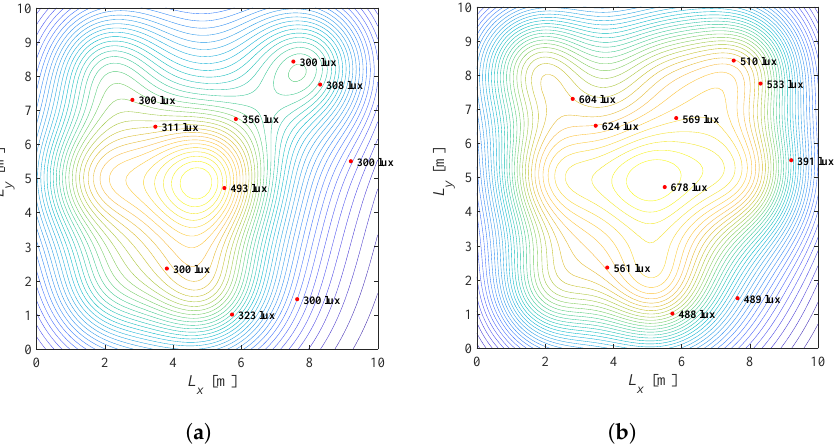
Figure 13. Solution of the Problem 3 defined in (19). ( a ) λ = 0.01, G = 0.42. ( b ) λ = 0.5, G =